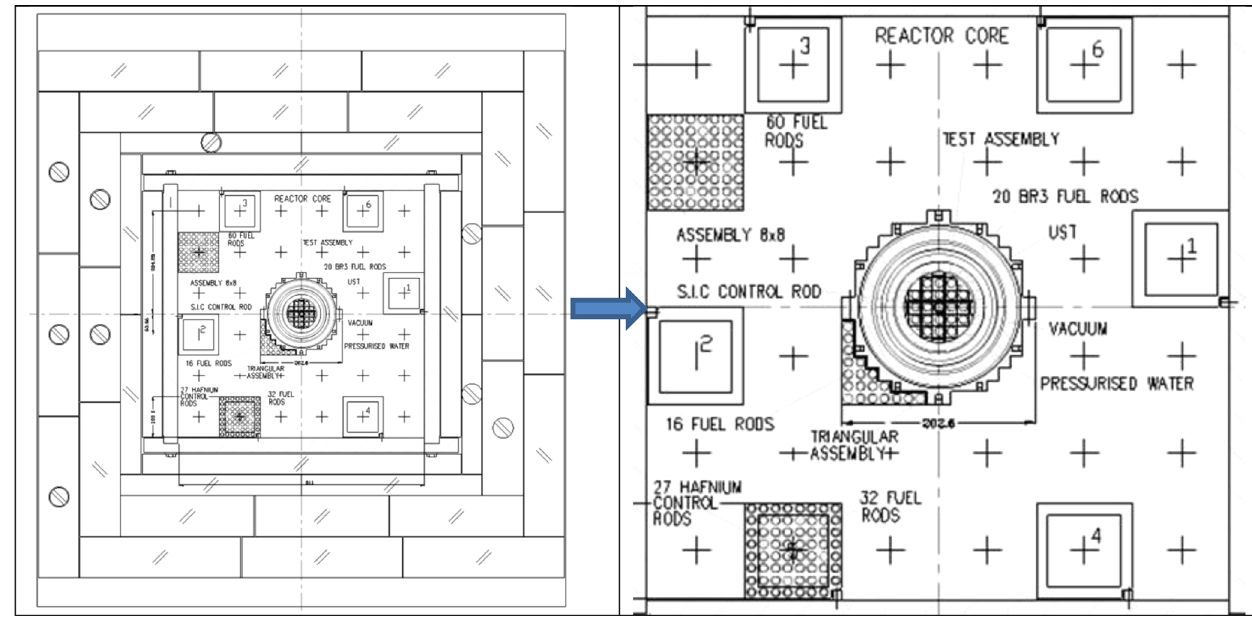
Fig. 3. PHEBUS core lay out.